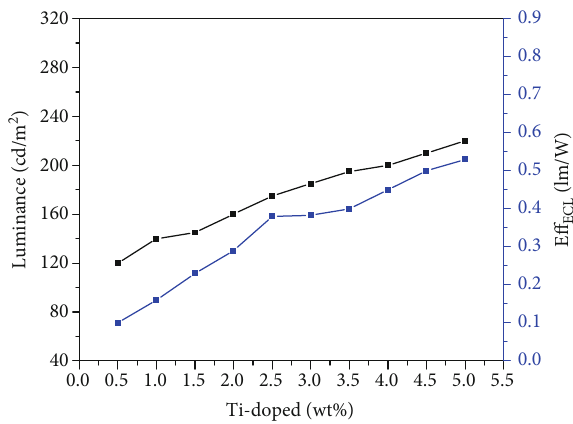
Figure 8: The luminance and ECL e ffi ciency of the deposited ITiO fi lms ’ di ff erent doping concentrations from Ti-0.5wt% to Ti- 5.0 wt%.